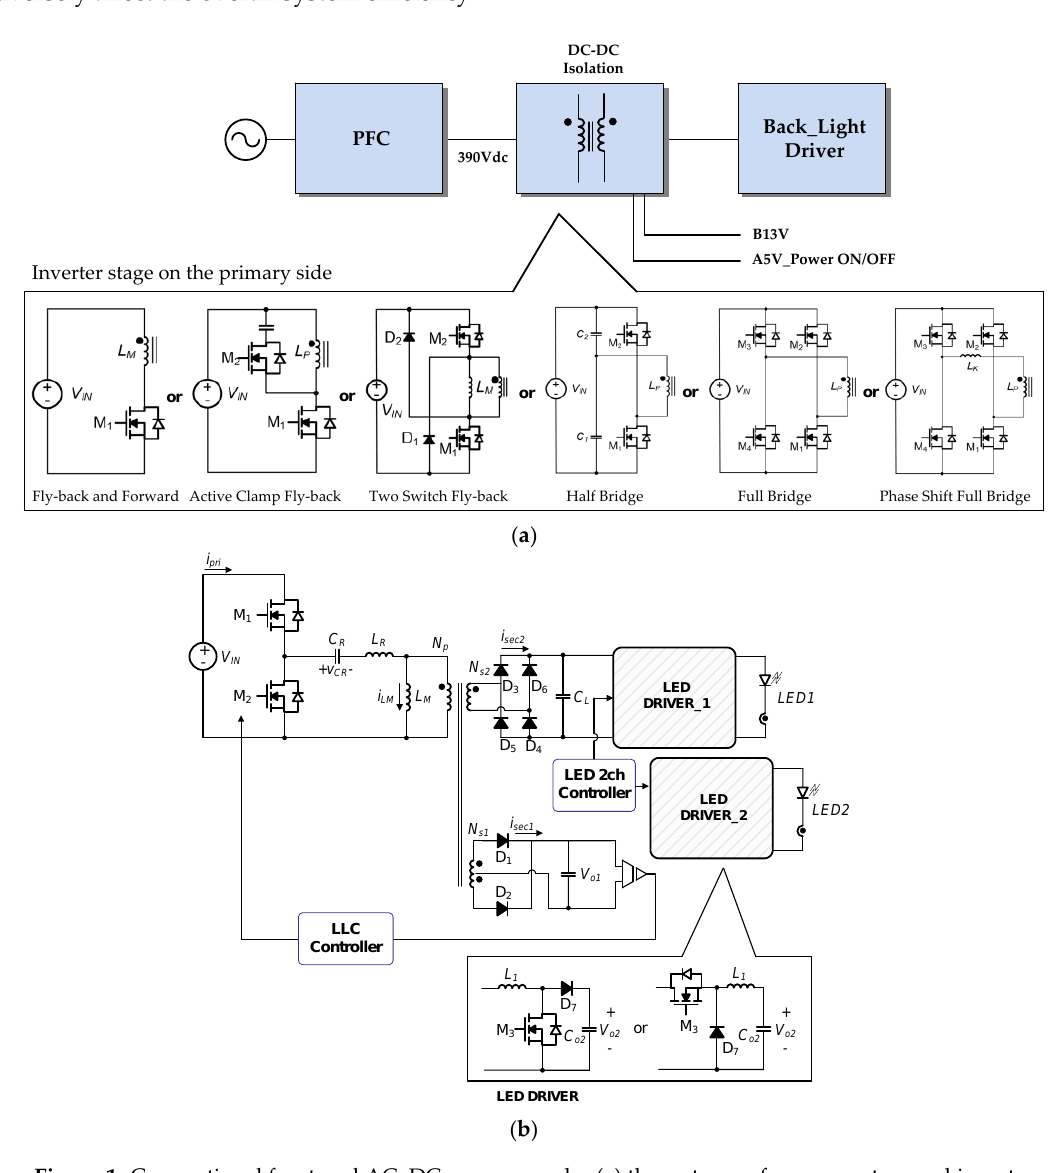
Figure 1. Conventional front-end AC–DC power supply: ( a ) three stages of power system and inverter stage on the primary side of the conventional converter; ( b ) schematic of conventional LED driving.